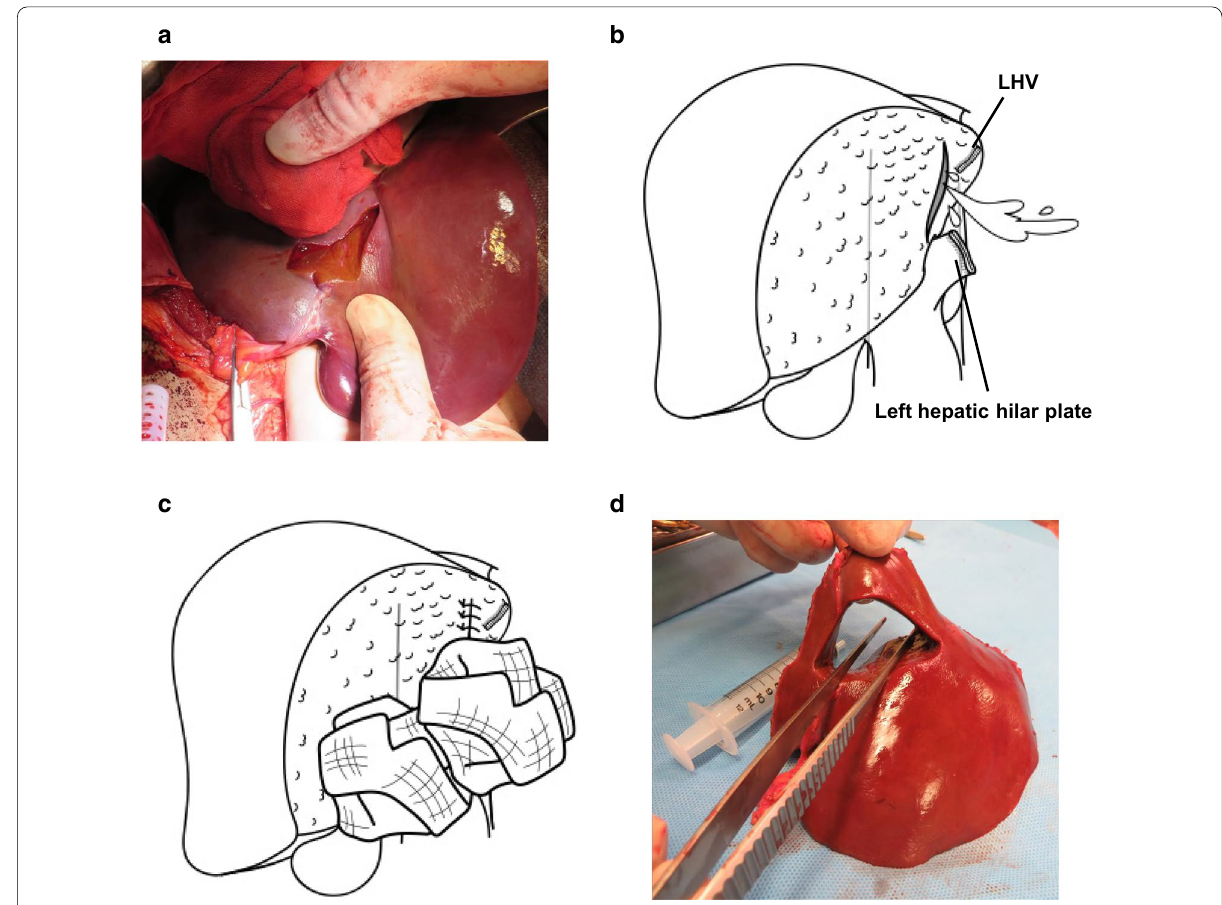
Fig. 1 Operative findings in the damage control surgery. a A stab incision on the surface of the left liver. b The laceration of the liver parenchyma reached deeper into the resection surface after left hemihepatectomy, and bleeding persistently continued from the laceration. LHV, left hepatic vein. c Bleeding was controlled even suturing of the lacerated liver parenchyma and gauze packing. d In the resected specimen of the left liver,